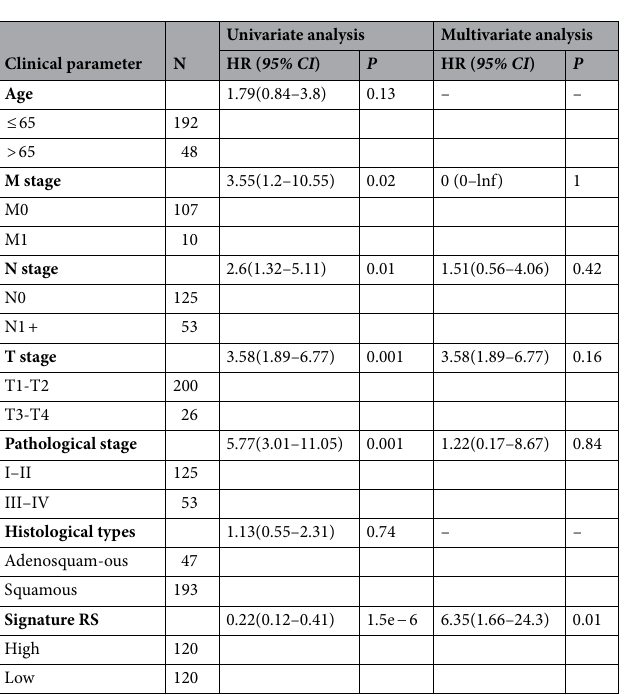
Figure 10. Kaplan–Meier and ROC curves based on the four-mRNA signature in CESC. ( A ) Kaplan–Meier survival curves showing OS outcomes according to relative high-risk and low-risk patients. ( B ) Time-dependent ROC analysis was performed to evaluate the prognostic ability of the four-mRNA signature for survival.